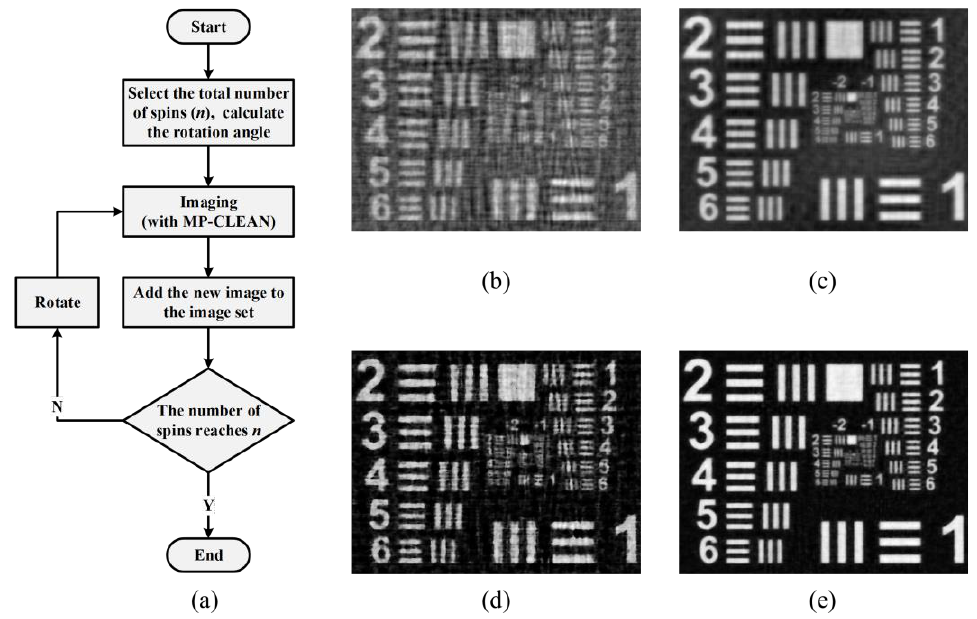
Figure 6. ( a ) The imaging process of segmented planar imaging system based on rotation and MP-CLEAN. ( b ) Imaging result of the conventional SPIDER before rotation without MP-CLEAN. ( c ) Imaging result of the conventional SPIDER after rotation without MP-CLEAN. ( d ) Imaging result of the parity-baseline segmented planar imaging system before rotation with MP-CLEAN. ( e ) Imaging result of the parity-baseline segmented planar imaging system after rotation with MP-CLEAN.